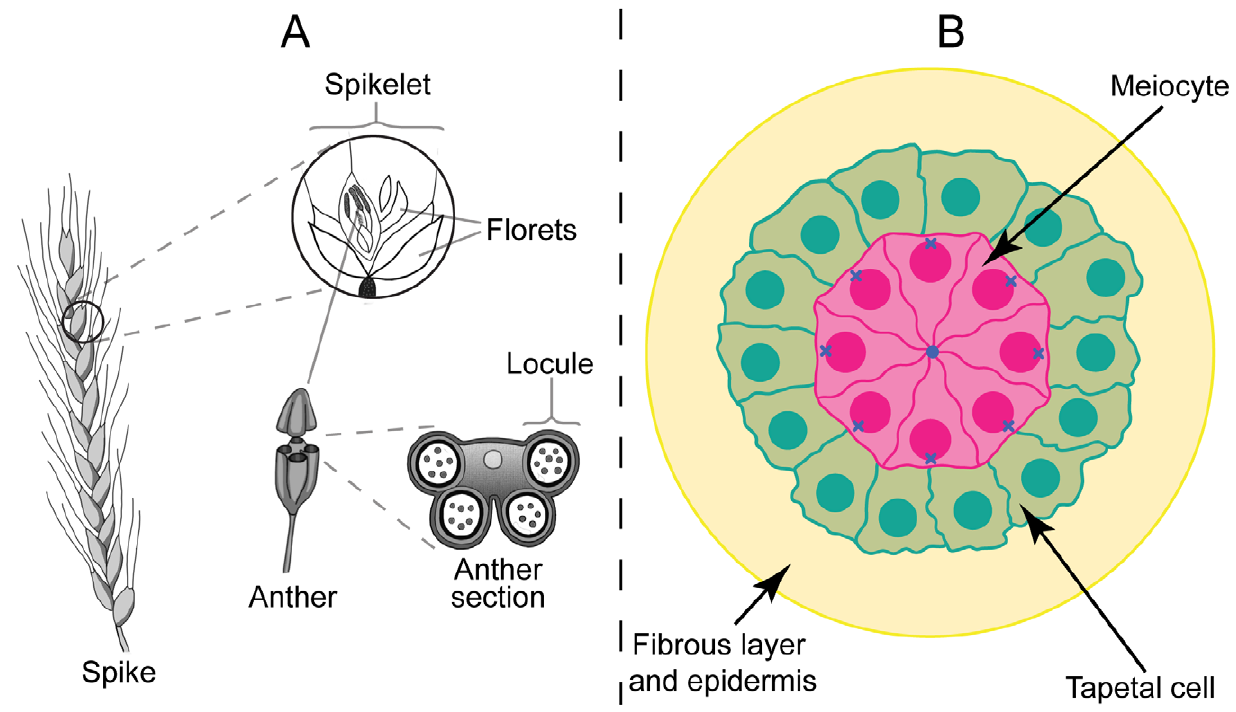
Figure 1. Structure of a wheat spike and anther, showing the position of the meiocytes. A. Sketch of a wheat spike, showing spikelets, florets and anthers. Each anther contains four locules. B. Sketch of the cross section of one of the locules within a wheat anther, with meiocytes in pink, tapetal cells in green and the remaining cells in yellow (not shown in detail). Solid circles represent nuclei and blue crosses show the outside pole of each meiocyte nucleus, where the telomere bouquet normally forms.